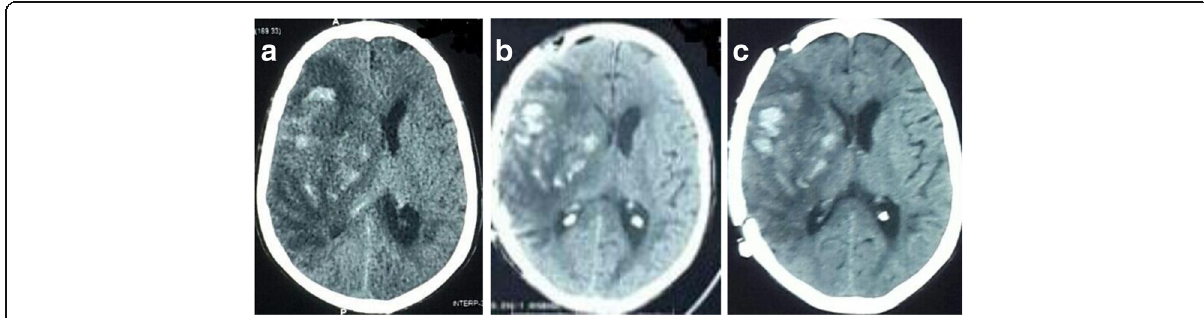
Fig. 1 a 65-year-old male patient with malignant right-sided MCA infarction, preoperative GCS 7/15, and preoperative midline shift 12 mm. b